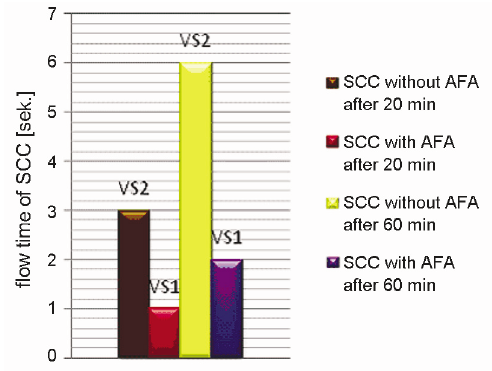
Fig. 15. The change of initial flow time of SCC with and with- out AFA. Symbols VS1 and VS2 represent viscosity classes according to Table 2